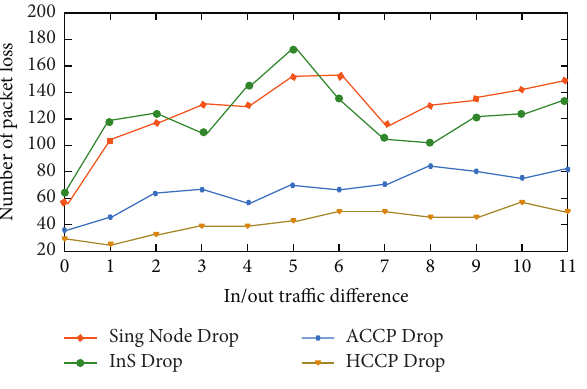
Figure 6: Changes in the throughput.